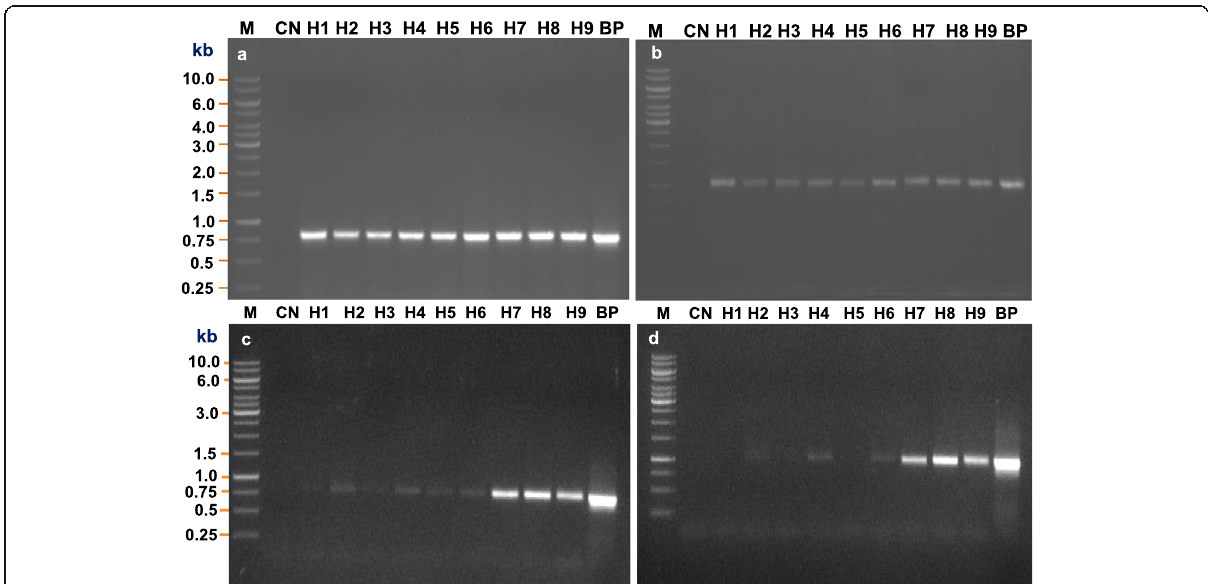
Fig. 5 Molecular analysis of in planta T 1 transgenic horse gram plants. a , b Genomic DNA was isolated from control (CN) and nine putative T 1 transgenic horse gram leaf samples and the PCR analysis performed using NPT II ( a ) and GUS ( b ) gene-specific primers, respectively. c , d RT-PCR analysis of transgenic horse gram plants using NPT II c and GUS d gene-specific primers, respectively. Total RNA was isolated from control and putative transgenic lines and then converted to the single-stranded cDNA and performed the RT-PCR to study the expression of NPT II and GUS transcript. Note: 796 bp and 1.0 kb PCR products were observed in all transgenic plants except control (CN) using NPT II and GUS gene-specific primer, respectively. M 1.0 kb DNA ladder (Fermentas, Thermo Scientific), CN control plant, H1 – H9 different transgenic lines, BP E. coli